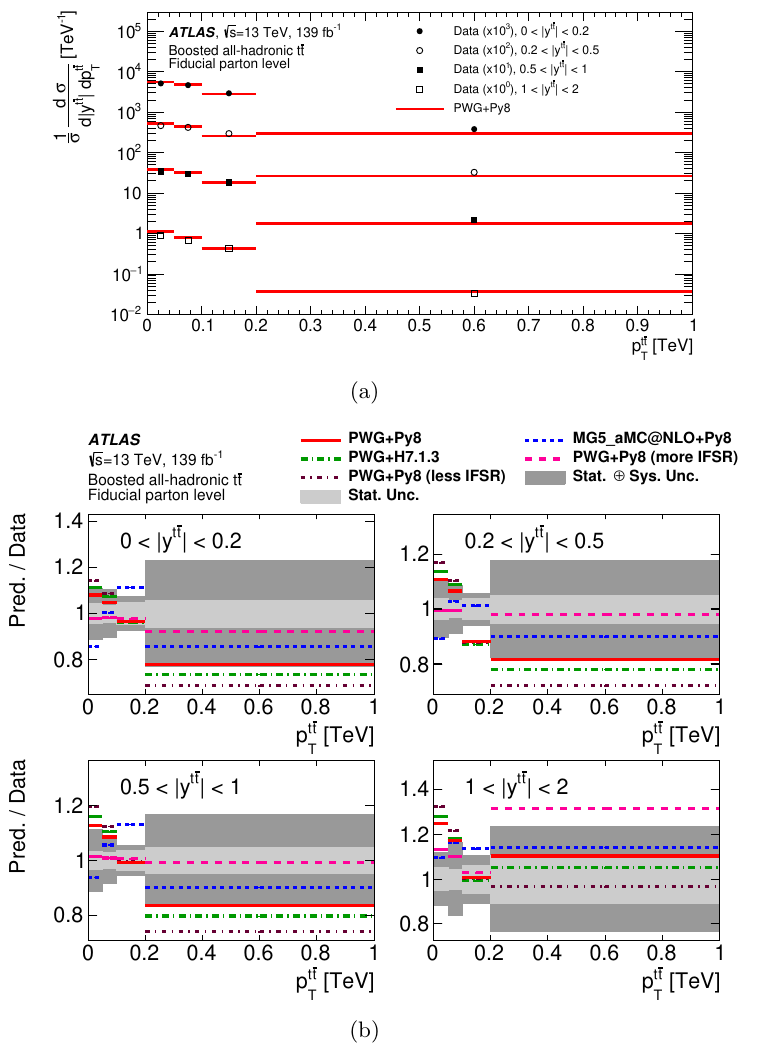
Figure 31 . (a) Normalized parton-level fiducial phase-space double-differential cross-sections as a function of the absolute value of the rapidity and the p T of the t ¯ t system, with the Powheg+Pythia 8 calculation. Data points are placed at the centre of each bin and the Powheg+Pythia 8 calculation is indicated by solid lines. The measurement and the prediction are normalized by the factors shown in parentheses to aid visibility. (b) The ratios of various MC calculations to the normalized parton-level fiducial phase-space differential cross-sections. The dark and light grey bands indicate the total uncertainty and the statistical uncertainty, respectively, of the data in each